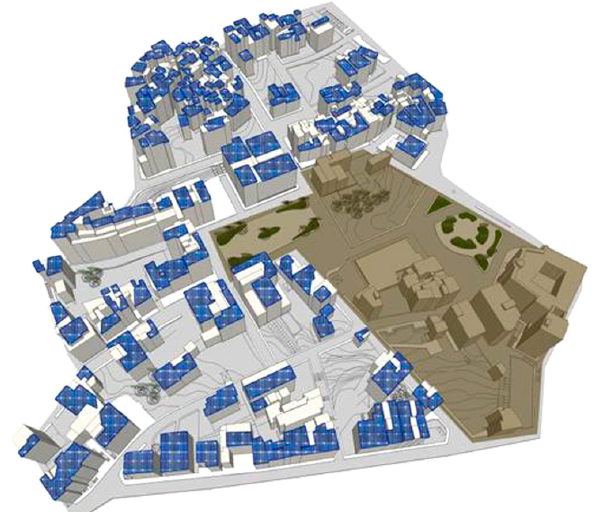
Figure 12. Rendering view of the available areas for the installation of solar photovoltaic panels in the quarter surrounding the city hall.